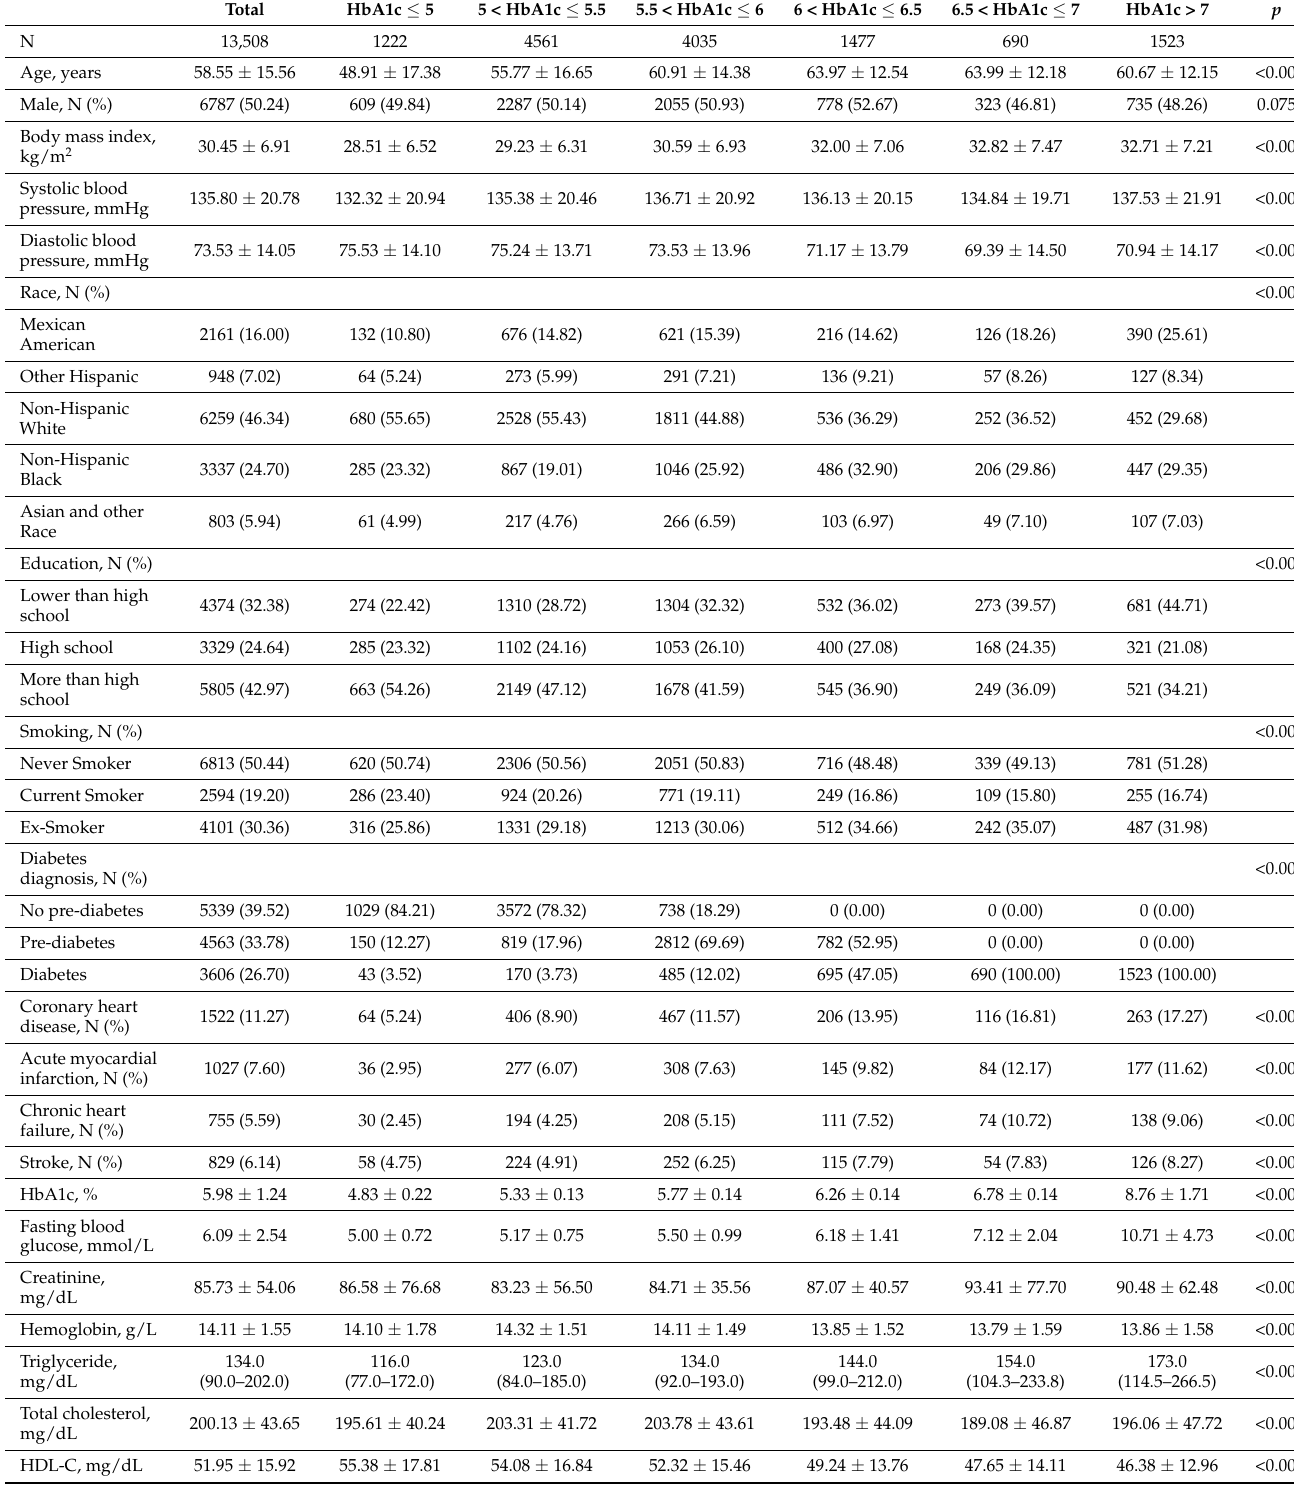
Table 1. Baseline characteristics according to HbA1c